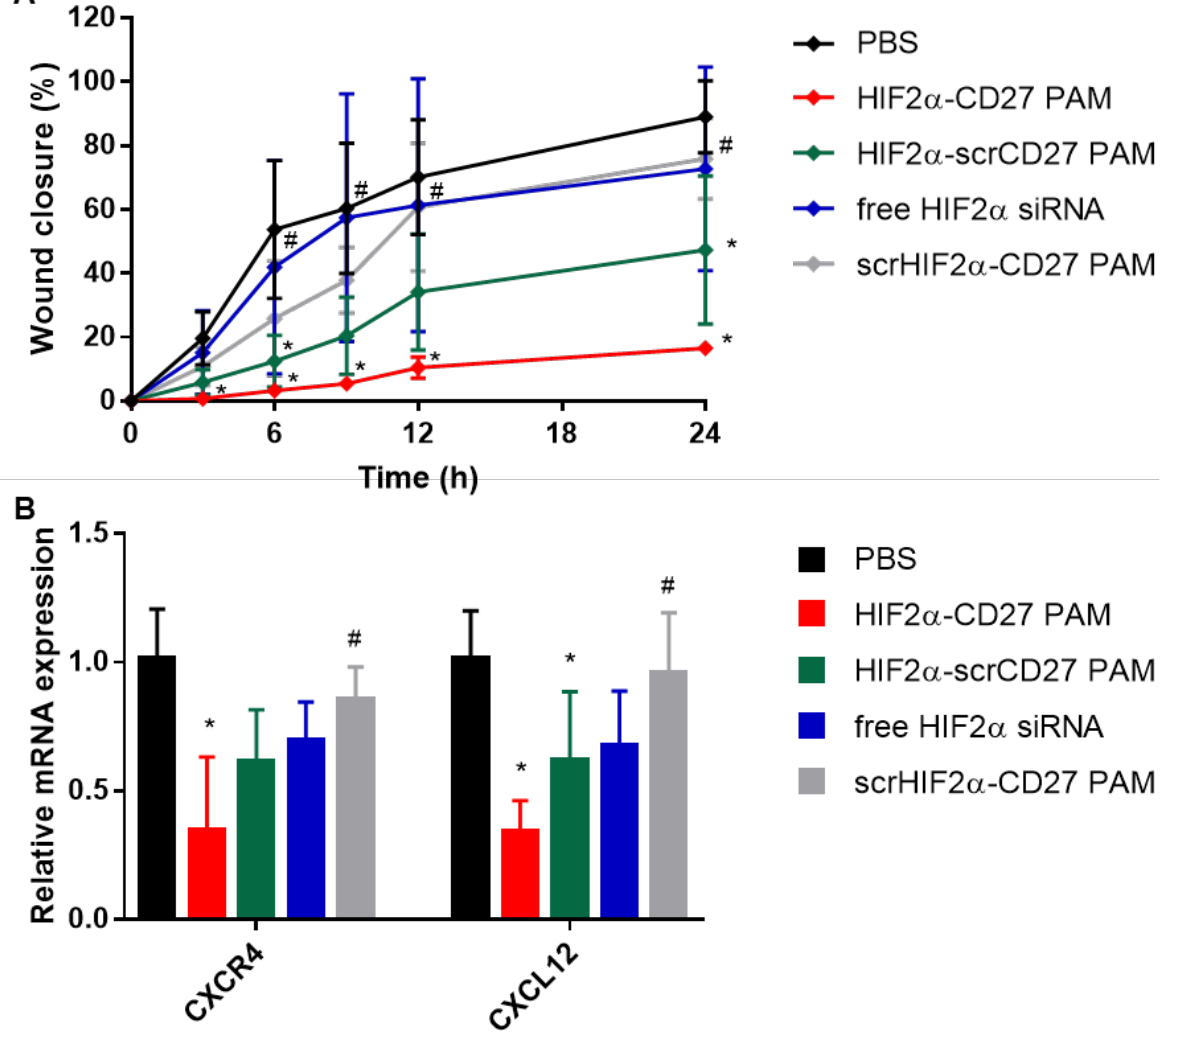
Figure 7. Effect of HIF2 α -CD27 PAMs on ccRCC migration. ( A ) The 48 h HIF2 α -CD27 PAM treatment (500 nM siRNA) slows wound closure of ccRCC cells over 24 h compared to PBS and free siRNA treatment. ( B ) The 48 h HIF2 α -CD27 PAM treatment (500 nM) reduces mRNA expression of CXCR4 (left) and CXCL12 (right). N = 4 or 5. * p < 0.05 relative to PBS. # p < 0.05 relative to HIF2 α -CD27 PAMs.